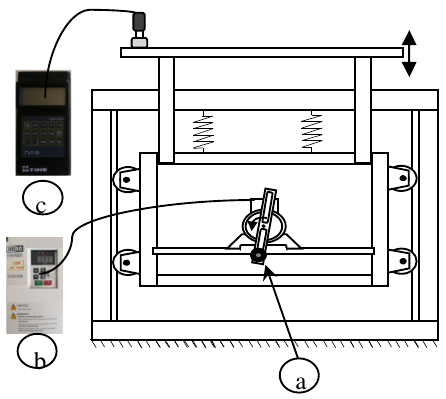
Fig. 5. Schematic diagram of the shaker with the measuring instruments